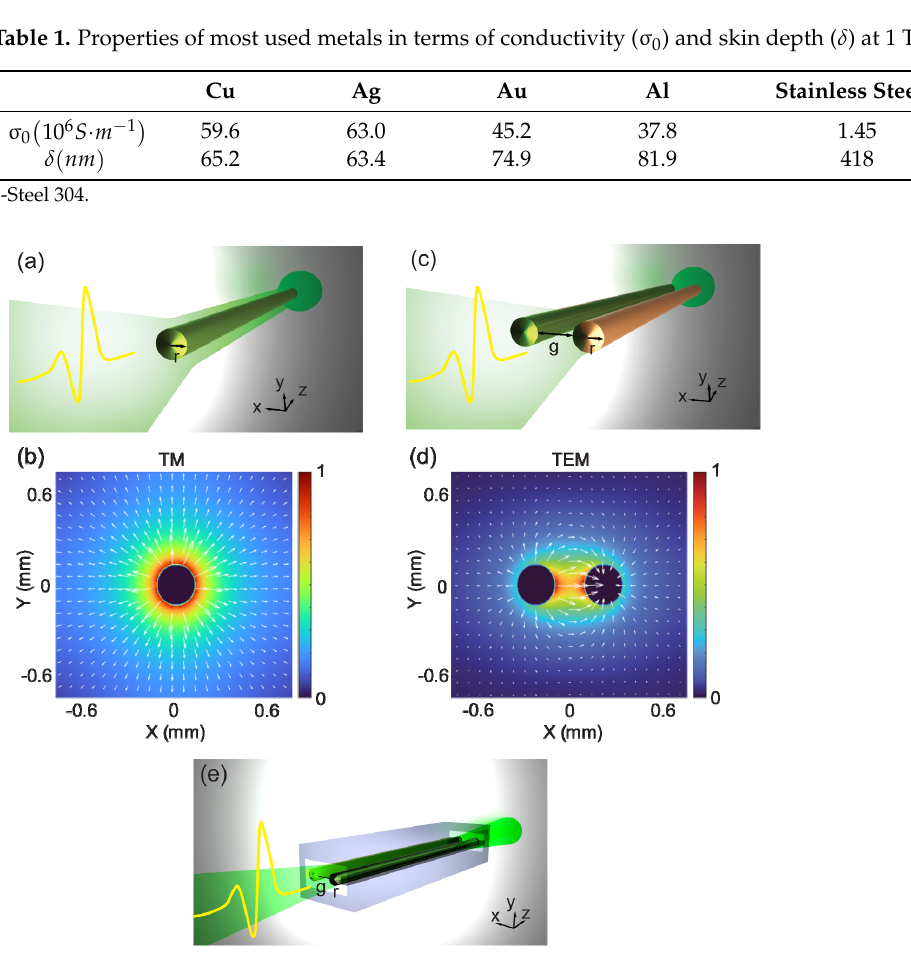
Figure 1. Schematics of typical THz metal − wire waveguides and their fundamental modes. ( a ) Schematic of the SWWG with a wire radius r = 127 µ m. ( b ) Simulated electric field distribu- tions of the fundamental TM mode at 0.5 THz. ( c ) Schematics of the TWWG waveguide with a wire radius r = 127 µ m and an air gap g = 300 µ m. ( d ) Simulated electric field distributions of the fundamental TEM mode at 0.5 THz. ( e ) The TWWG (wire radius r = 330 µ m and the air gap directions of local field polarization